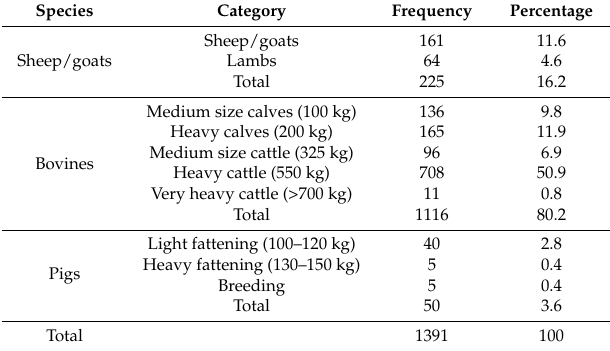
Table 1. Frequency table by category of animal transported for the 1391 trucks which stopped at control post CE 07/PS Bitritto (Bari, Italy) from 2010 to